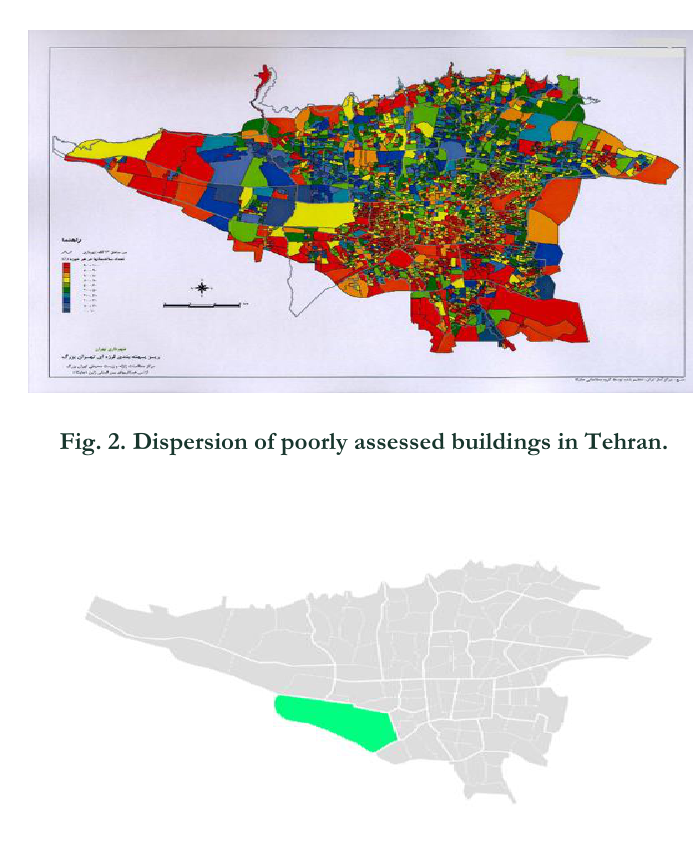
Fig. 3. District 18 of Tehran Municipality.